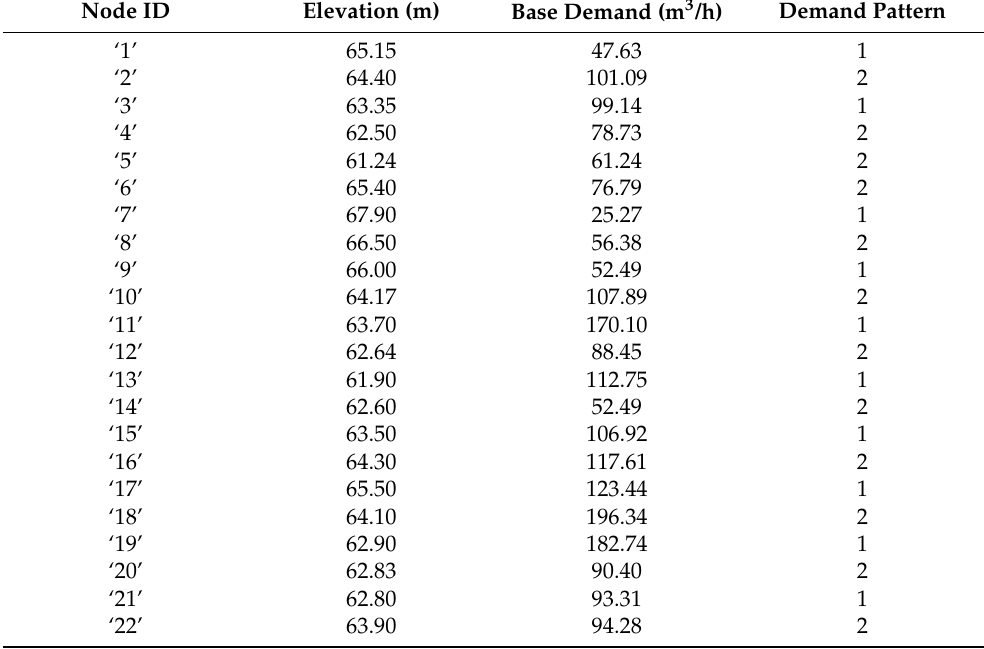
Table 2. Fossolo network—node